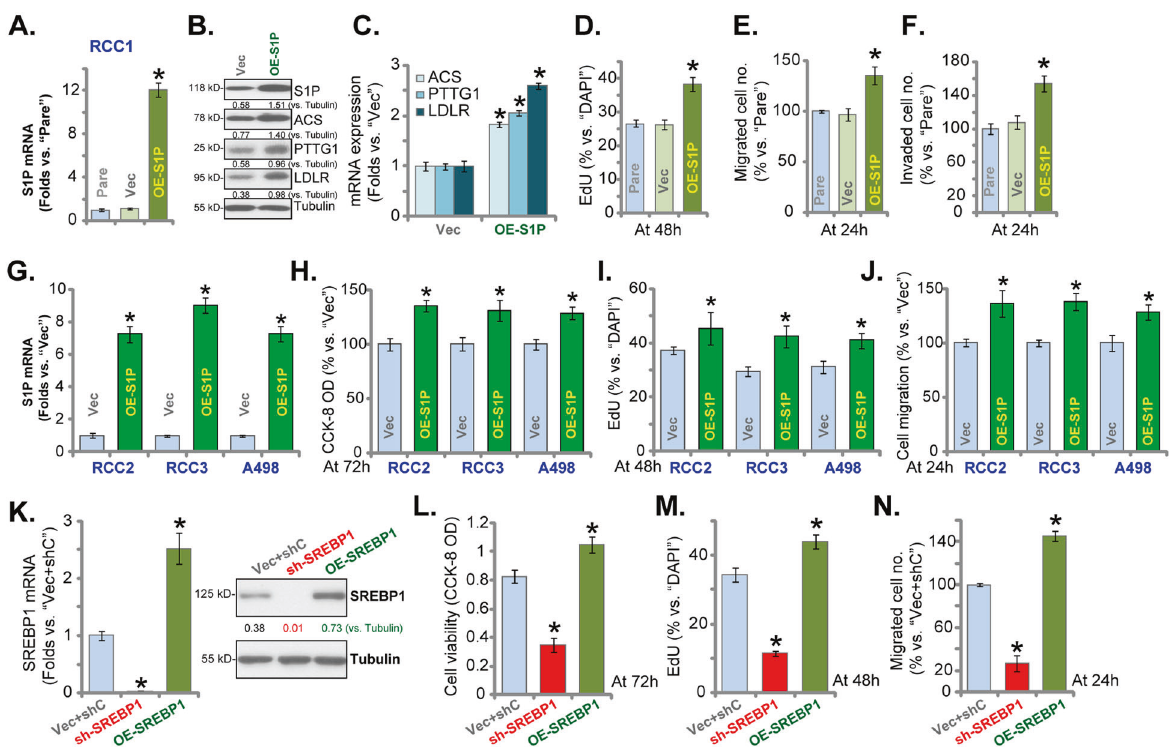
Fig. 4 S1P overexpression promotes RCC cell proliferation and migration. Primary RCC cells ( “ RCC1/RCC2/RCC3 ” ) or A498 cells, bearing the lentiviral S1P expression construct ( “ OE-S1P ” ) or empty vector ( “ Vec ” ), were established, expression of listed genes in these cells and parental control cells ( “ Pare ” ) was shown ( A – C and G ). Cells were further cultured for applied time periods, CCK-8 OD ( H ), proliferation (by recording nuclear EdU ratio, D and I ), migration, and invasion ( “ Transwell ” assay, E , F , and J ) were tested. RCC1 cells bearing SREBP1 shRNA ( “ sh-SREBP1 ” ) or SREBP1-expressing construct (OE-SREBP1) were established, control cells were transduced with scrambled control shRNA plus empty vector ( “ Vec + shC ” ), expression of SREBP1 mRNA and protein was shown ( K ). Cells were further cultured for applied time periods, viable cell number ( L ), proliferation ( M ), and migration ( N ) were tested similarly. For each assay, n = 5. Data were expressed as the mean ± standard deviation (SD). * P < 0.05 vs. “ Vec ” / “ Vec + shC ” group. In this fi gure, experiments were repeated three times, and similar results were obtained each